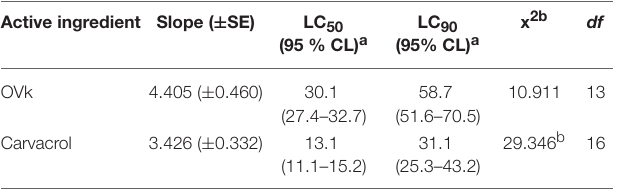
TABLE 5 | LC 50 and LC 90 values for Origanum vulgare ssp hirtum EO (OVk) and its major component, carvacrol, against third to fourth instar larvae of Ae. albopictus